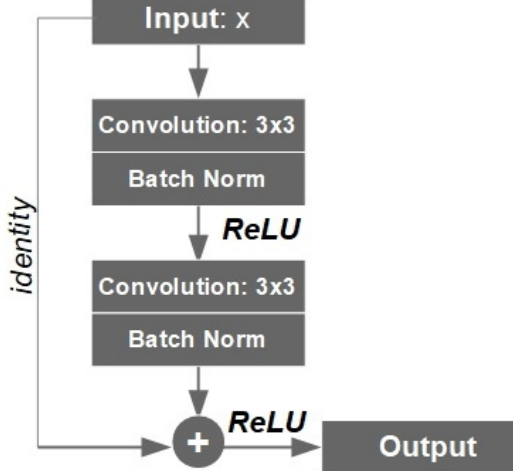
Figure 6. An example of ResBlock within a residual network.